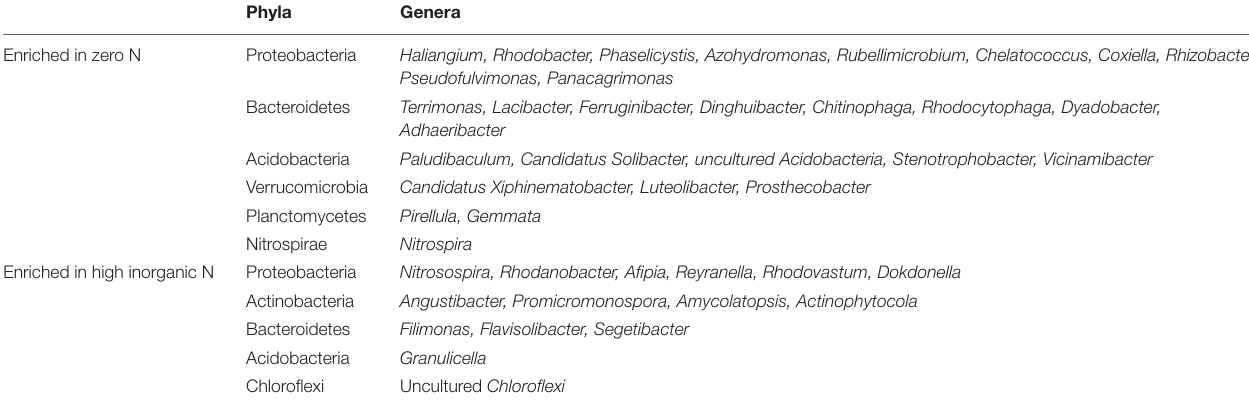
TABLE 4 | Differentially abundant genera which were found to be enriched in samples not receiving any N and samples receiving high inorganic N.